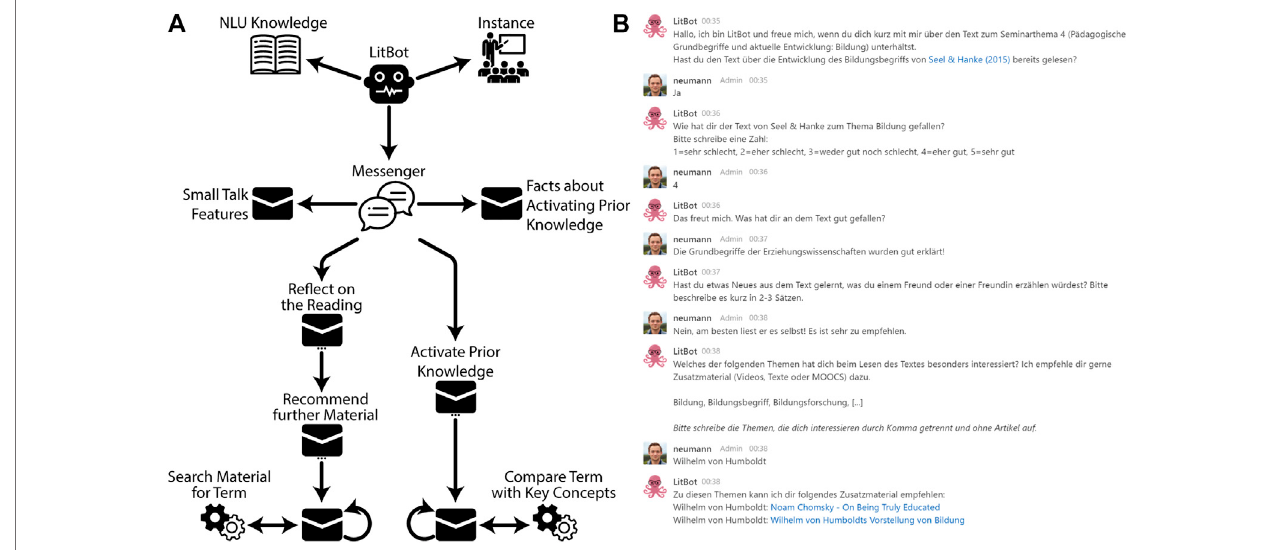
FIGURE 3 | (A) Simpli fi ed model of the LitBot . Messages grouped by functional scope. (B) Rocket.Chat conversation with LitBot (greeting, getting material recommendations).